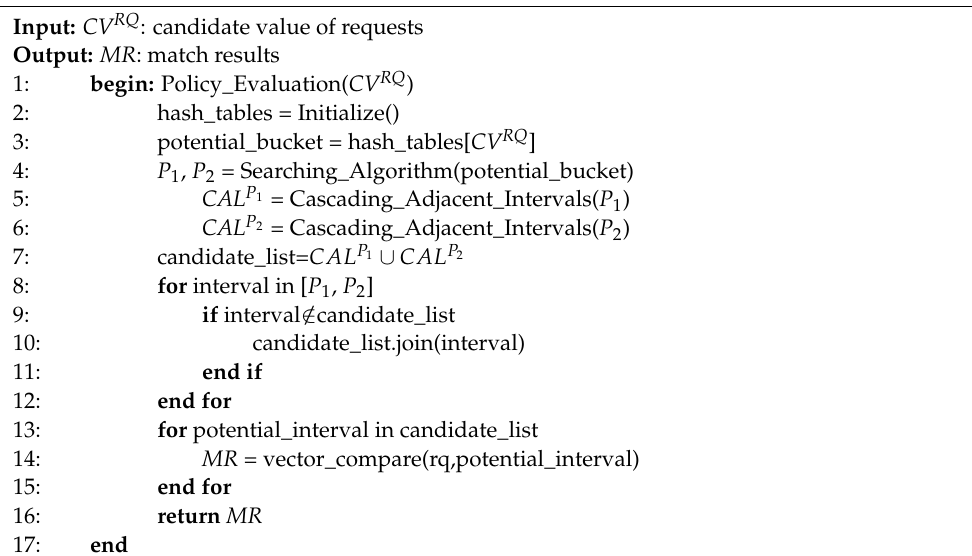
Algorithm 3: Interval Policy Match